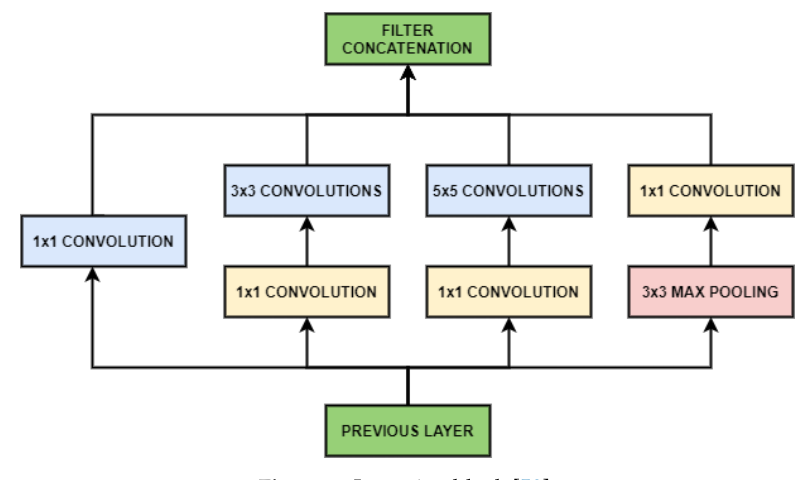
Figure 8. Inception block [50].